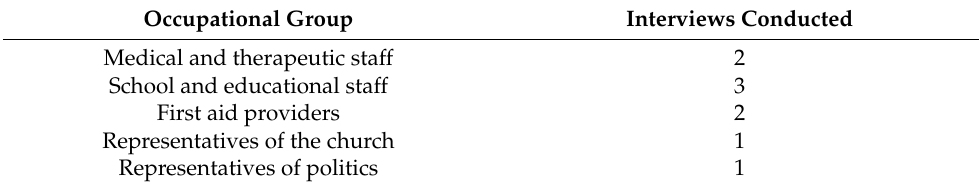
Table 3. Distribution of occupational groups of the interview